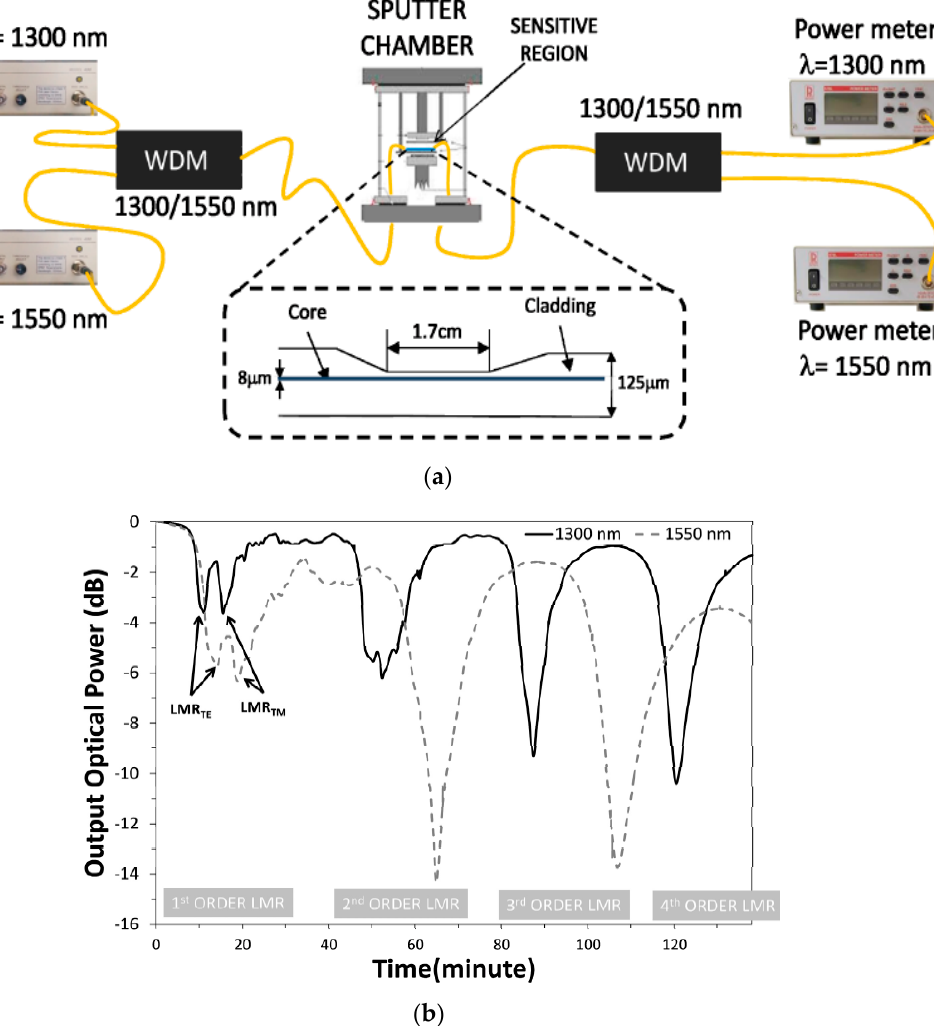
Figure 6. ( a ) Schematic view of experimental setup for the fabrication process of ITO and D − shaped fiber; ( b ) variation of output optical power with deposition time (coating thickness) at 1300 nm and 1550 nm. Reprinted with permission from [77], copyright The Optical Society.